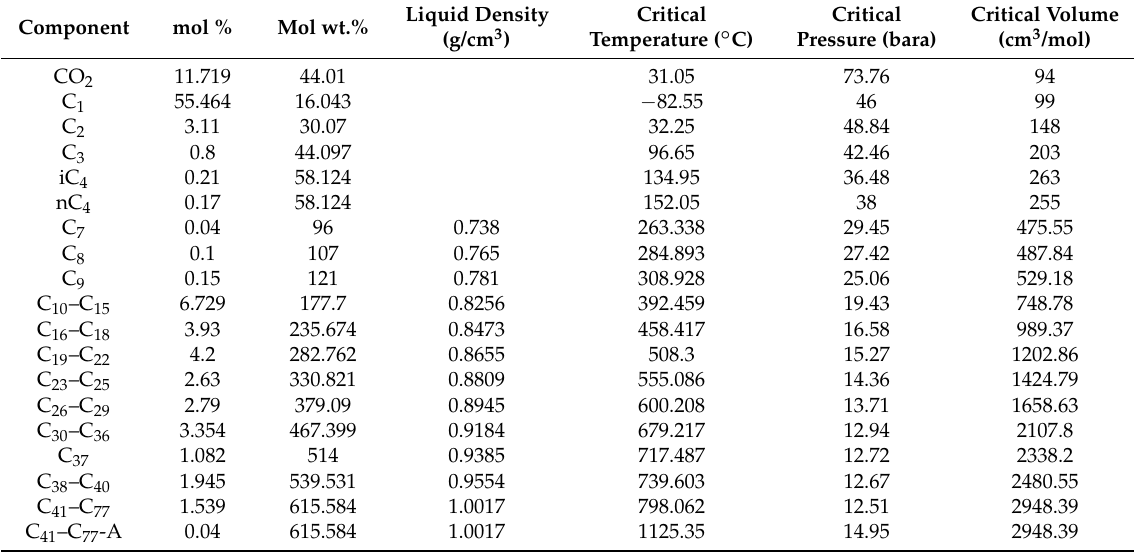
Table 5. Composition and critical parameters of pseudo-components in a buried-hill reservoir.